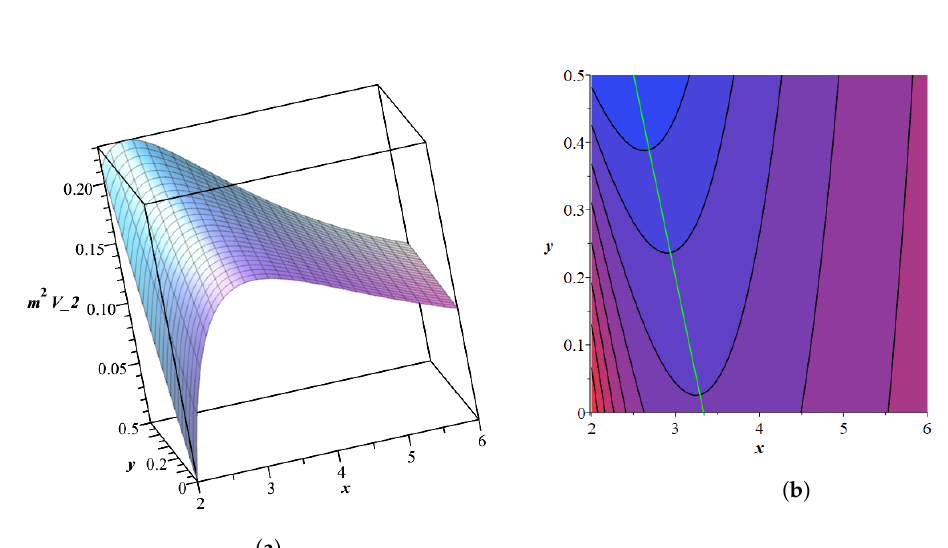
Figure 3. The qualitative features of the spin two axial Regge–Wheeler potential for the dominant multipole number (cid:96) = 2 are depicted. ( a ) Three-dimensional plot of m 2 V 2 . ( b ) Contour plot. ‘blue’ → ‘red’ corresponds to ‘high’ →